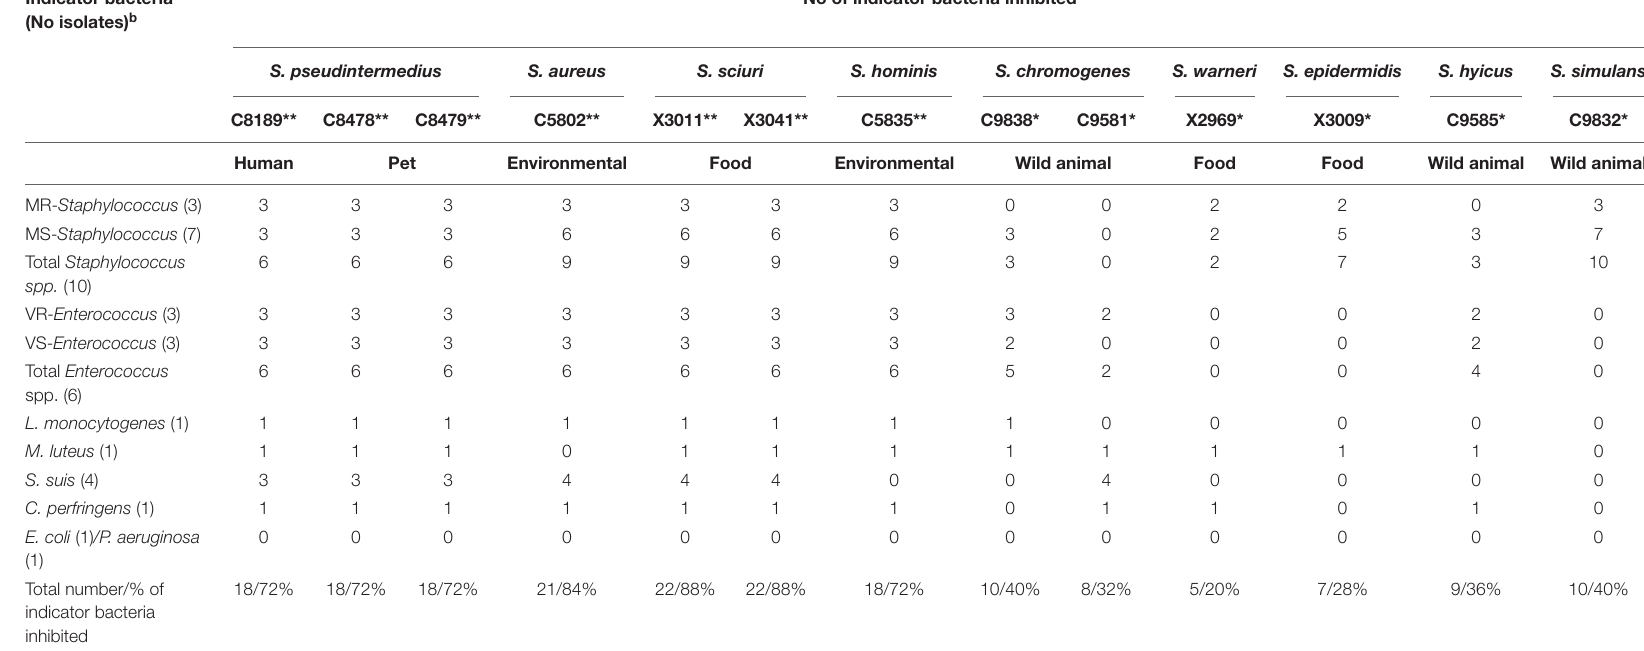
No of indicator bacteria